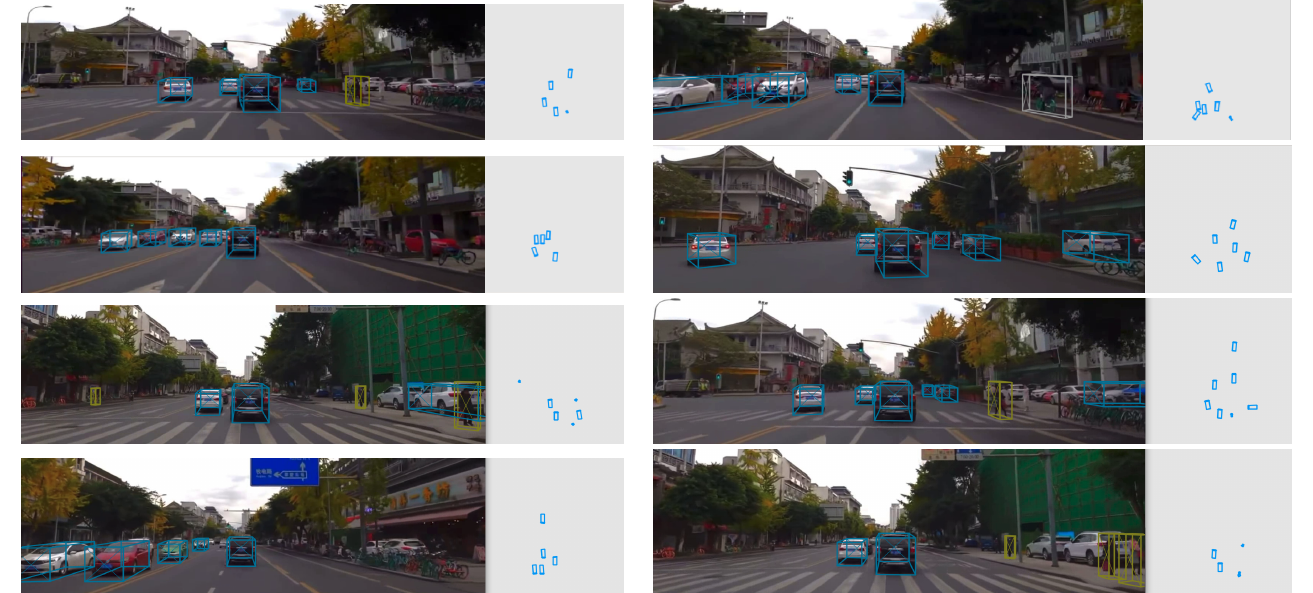
Figure 11. Real scenes application of the proposed Keypoint3D on the road of Chengdu, China. Cars, pedestrians, and cyclists are represented by pale blue, brown, and gray boxes, respectively. The heading direction is represented with a cross mark.